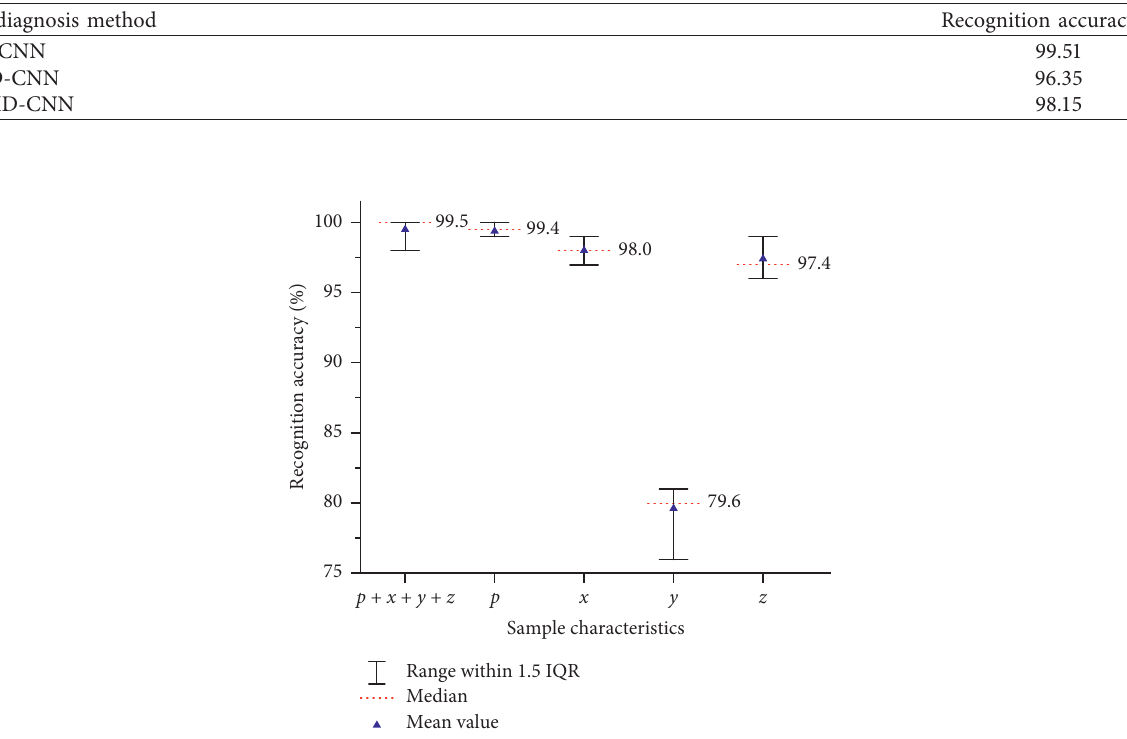
Figure 18: The accuracy rate of model recognition is affected by different characteristic parameters.